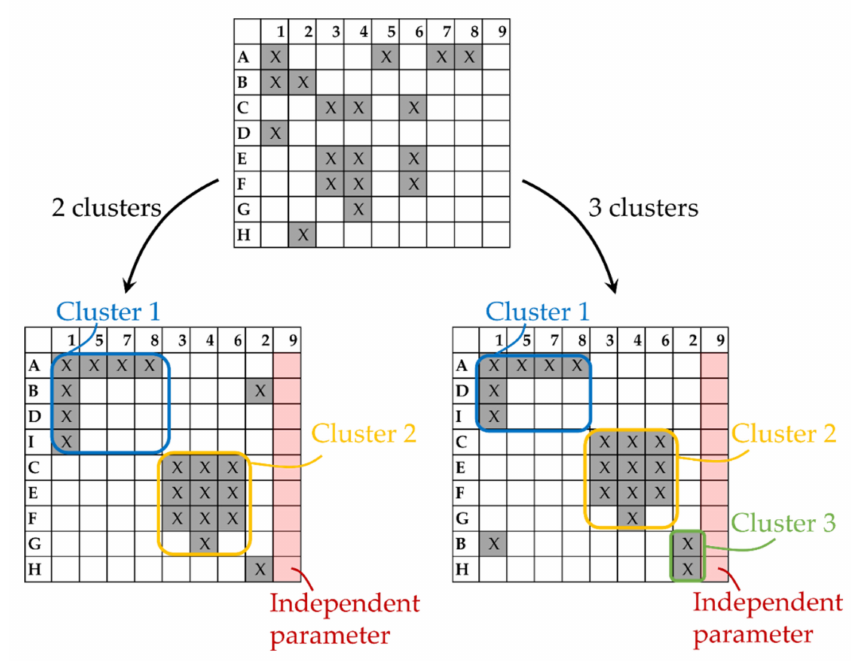
Figure 4. Example of DMM-clustering results depending on the number of clusters selected. Starting from a DMM where relationships of each row parameter with each column parameter are recorded, these relationships can be clustered in different ways, depending on the predefined number of clusters. Clustering results, if choosing two or three clusters, are shown here. A parameter with no recorded relationship is defined as an “independent